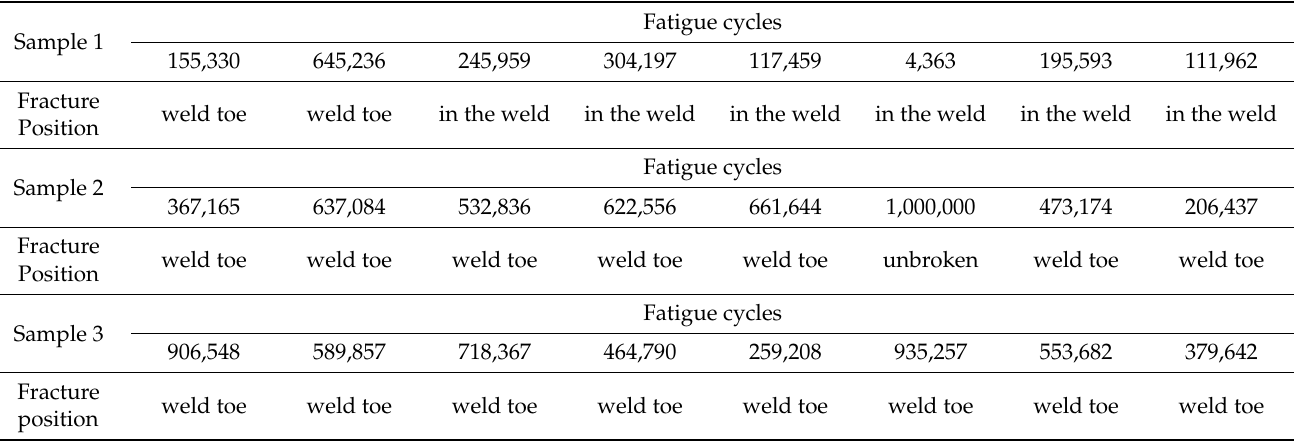
Table 5. Fatigue property test